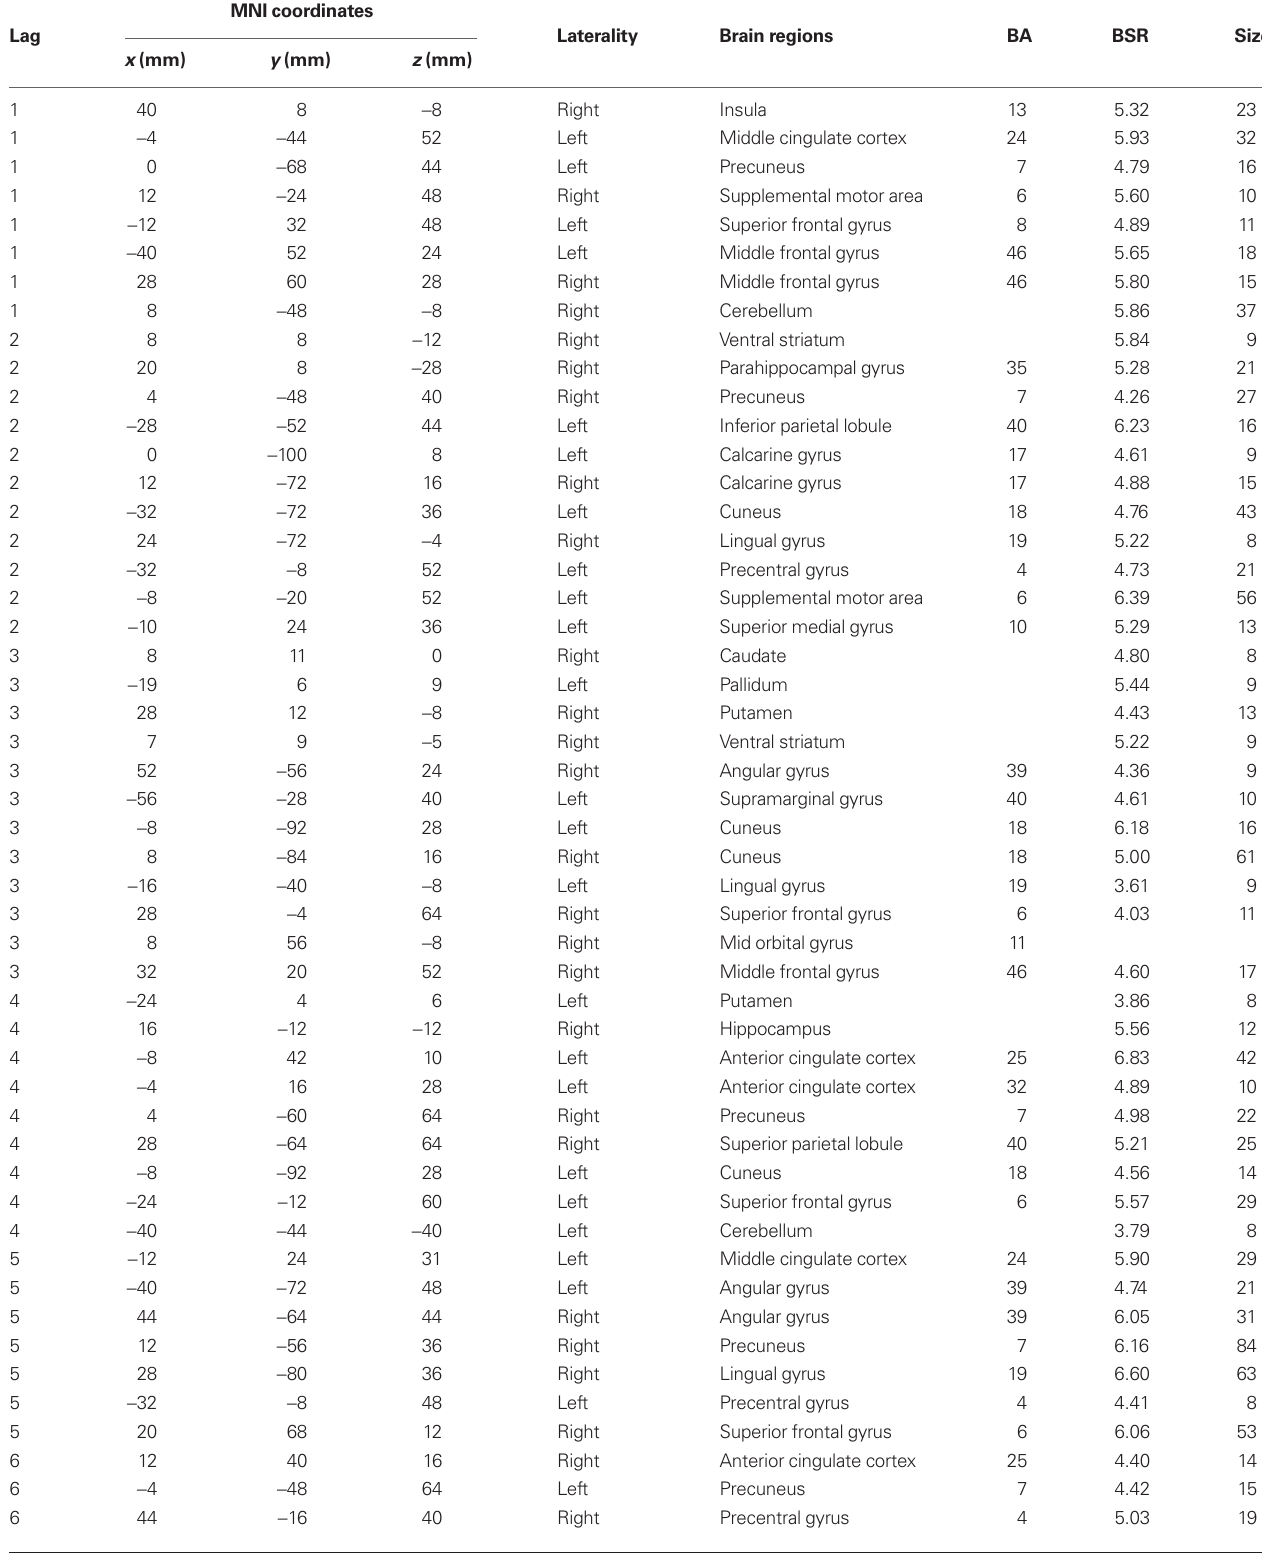
Table 3 | Stable voxels from mean-centered PLS analysis in the two groups (LV1 = 57.41% crossblock covariance, p < 0.012). MNI Lag